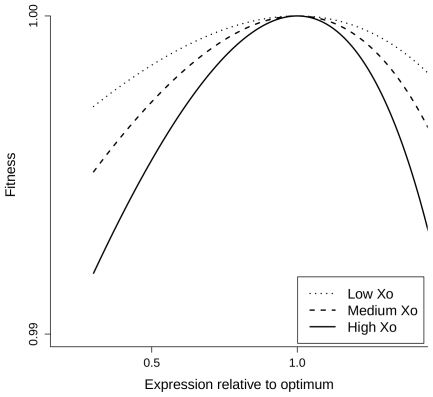
Fitness functions predicted by the COSTEX model for different values of optimal expression levels.These plots represent the fitness function w(x) for several values of X0. They were generated assuming an affine benefit function B(x) in equation (2) for increasing optimal expression levels X0: dotted, dashed and continuous lines for low, medium and high X0, respectively.